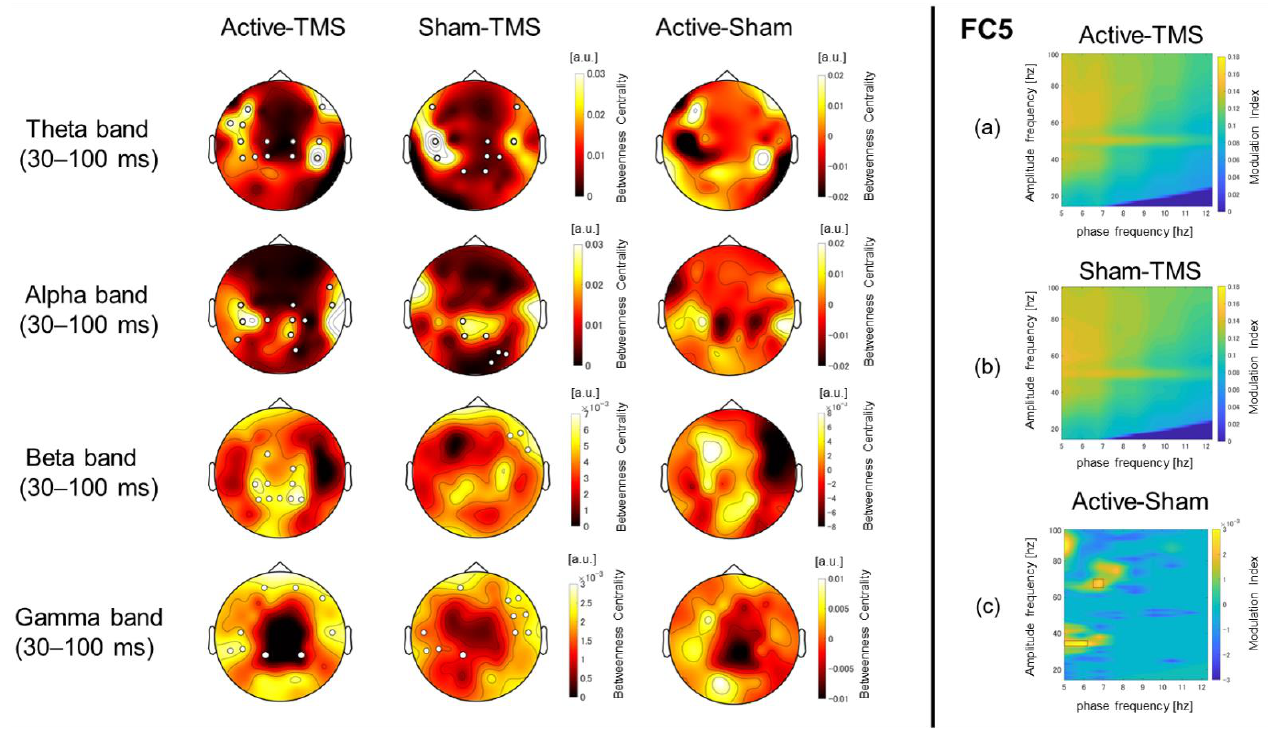
Figure 3. Graph theory-based network analyses for the wPLI and the comodulogram of phase–amplitude coupling expressed in the modulation index (MI). The left panel of Figure 3 shows the mean betweenness centrality of all participants in the active condition ( left column), the sham condition ( middle column), and the statistical map of differences between the active and sham conditions ( right column). Each panel shows the results of the theta-band (4 – 8 Hz), alpha-band (8 – 13 Hz), beta-band (13 – 30 Hz), and gamma-band (30 – 100 Hz) analysis, from top to bottom , respectively. The white circles in the figure indicate the electrode sites that were regarded as hubs in the whole brain network based on the following score criteria: (1) the top 20% with the lowest value of clustering coefficients, (2) the top 20% with the shortest path lengths, (3) the top 20% with the highest degree, and (4) the top 20% with the highest value of betweenness centralities (BC). On the other side, the right panel of Figure 3 represents the comodulogram at the left fronto-central area (i.e., FC5 electrode site) that showed a significant difference in the MI values between the active and sham conditions in the interval 30 – 200 ms after TMS stimulation. Here, (a – c) are comodulograms showing PAC findings in the active condition, sham condition, and the difference between the two conditions, respectively.